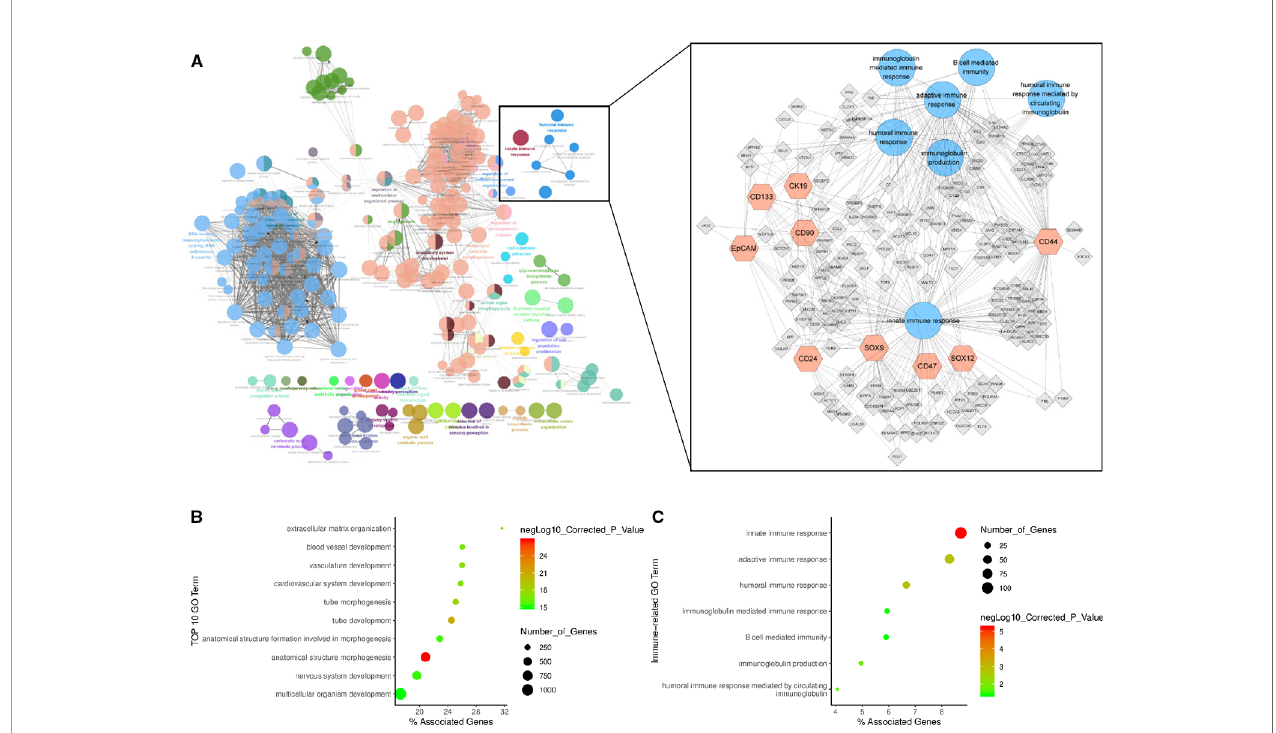
FIGURE 5 | HCSC markers related gene regulatory network. (A) HCSC markers related gene regulatory network. The network graph on the left shows all enriched GO items, with each dot representing a GO item. The network graph on the right is a detailed version of the immune-related GO items in the diagram on the left, with each dot representing a GO item, hexagon representing a HCSC mark gene, quadrilateral representing related gene, and line representing a correlation. (B) GO enrichment plot of biological function. (C) GO enrichment plot of immune related biological